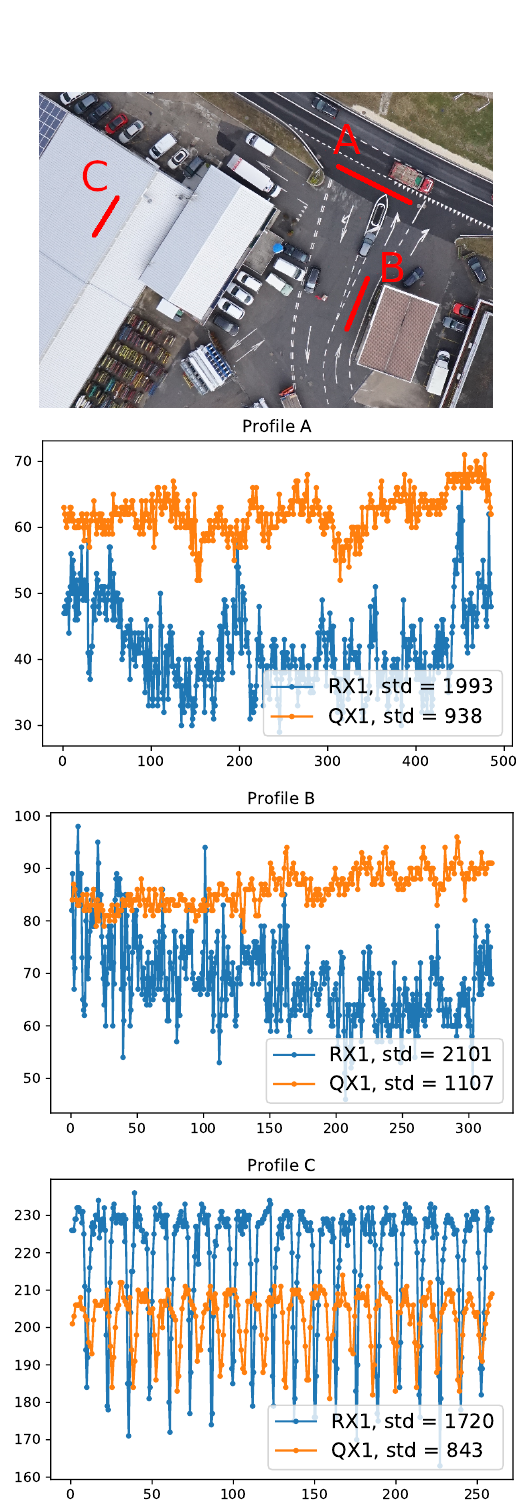
Figure 6: Radiometric profiles comparison between RX1 and QX1 camera on three areas A, B and C (bottom), and their lo- cations on the image (top). Profile C shows a better sharpness of RX1.